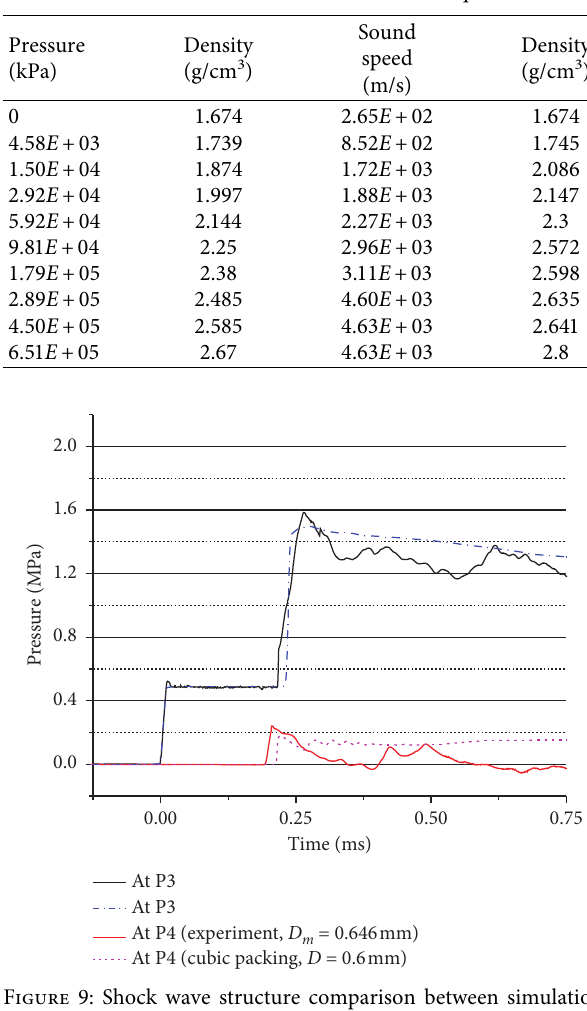
Table 1: Parameters of the SAND state